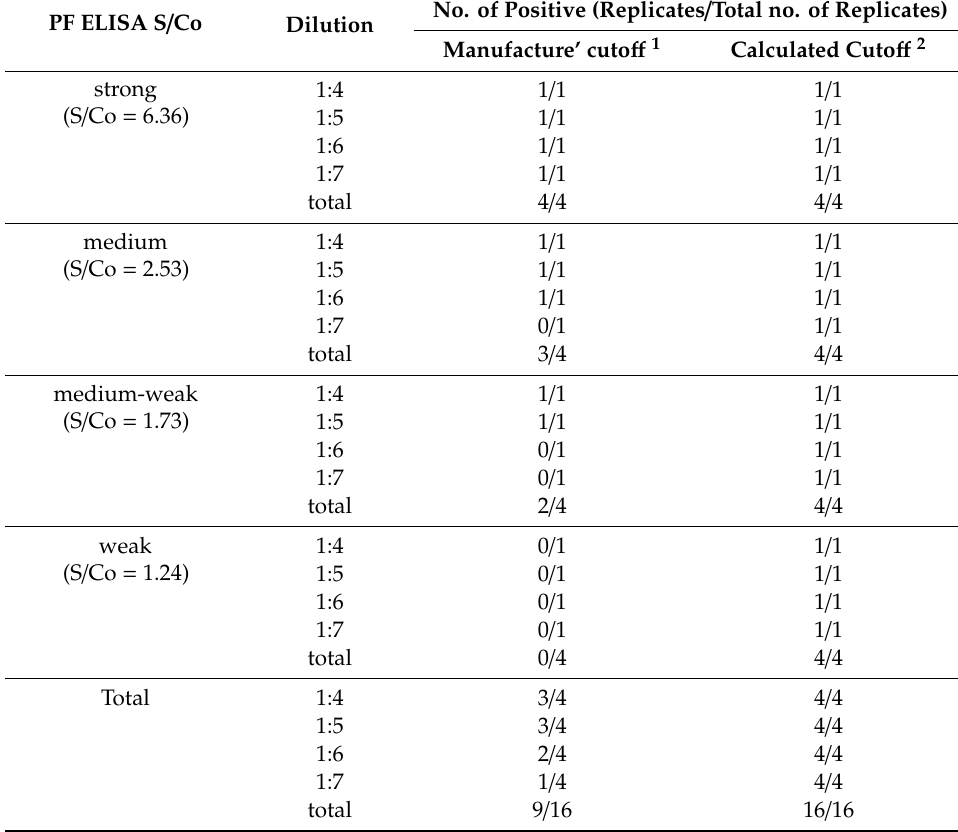
Table 5. The e ff ect of pooling one PF sample with high, medium, medium-low and low ELISA S / Co with three through 6 negative PF